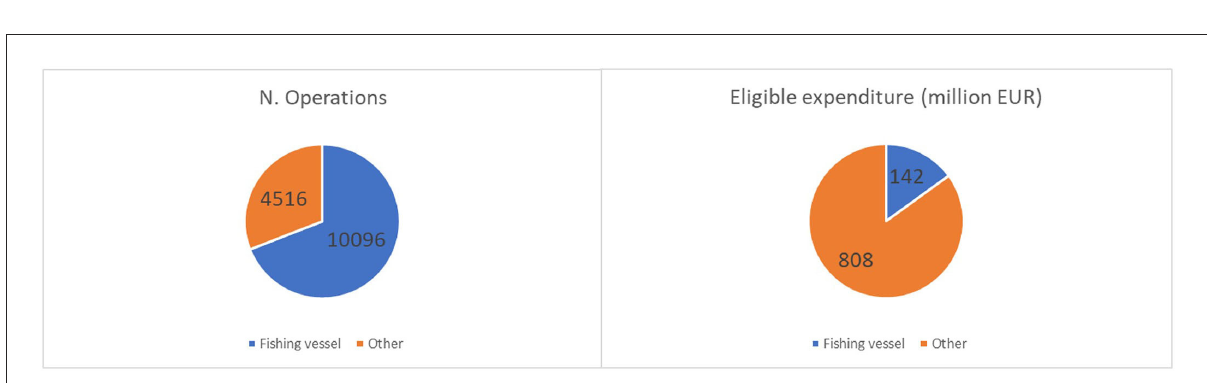
FIGURE2 EMFF measures related to the number of operations and eligible expenditure based on the typology of the beneficiary. Elaboration on data from the EMFF List of Operations and the EU Fleet Register of Italy, Croatia, Malta, Mediterranean Spain, and Mediterranean